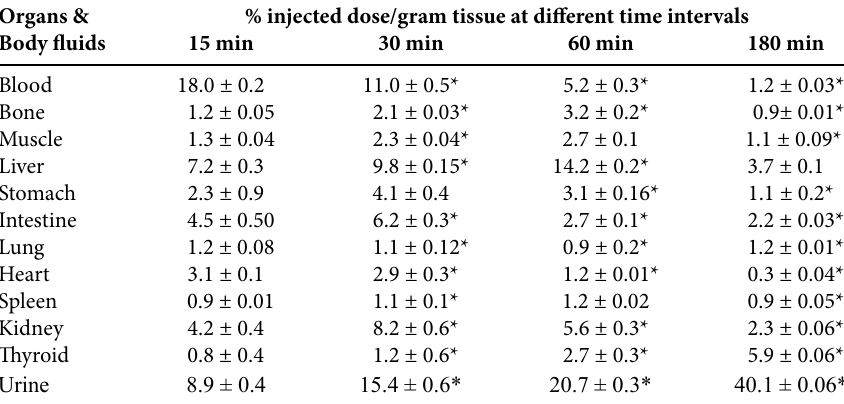
Table 9. Biodistribution of 125 I- TP 5 in normal mice Organs